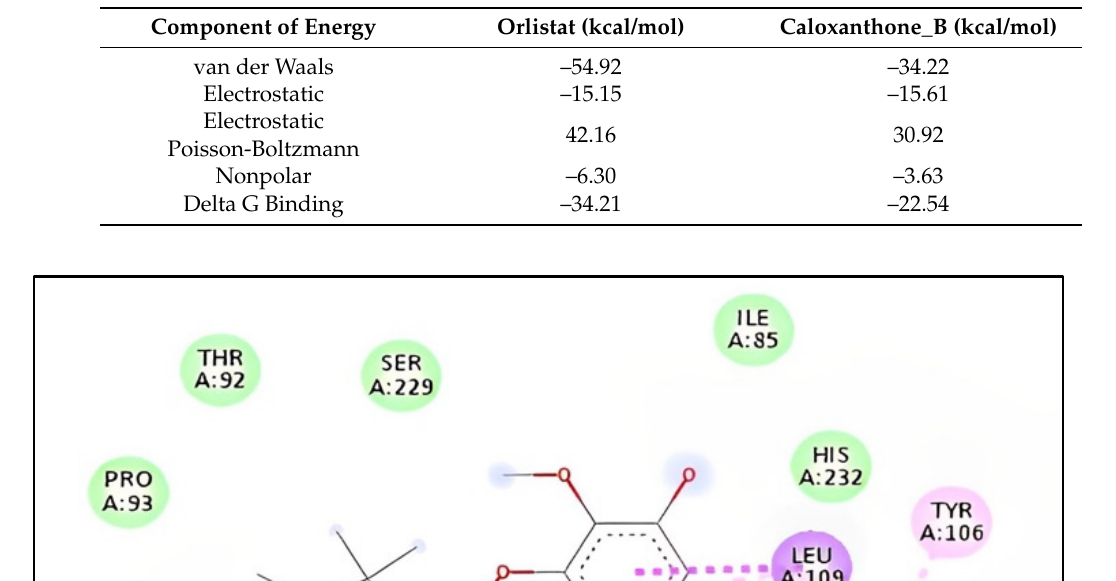
Table 7. Interaction energy of orlistat and caloxanthone B to fat mass and obesity-associated protein (FTO).